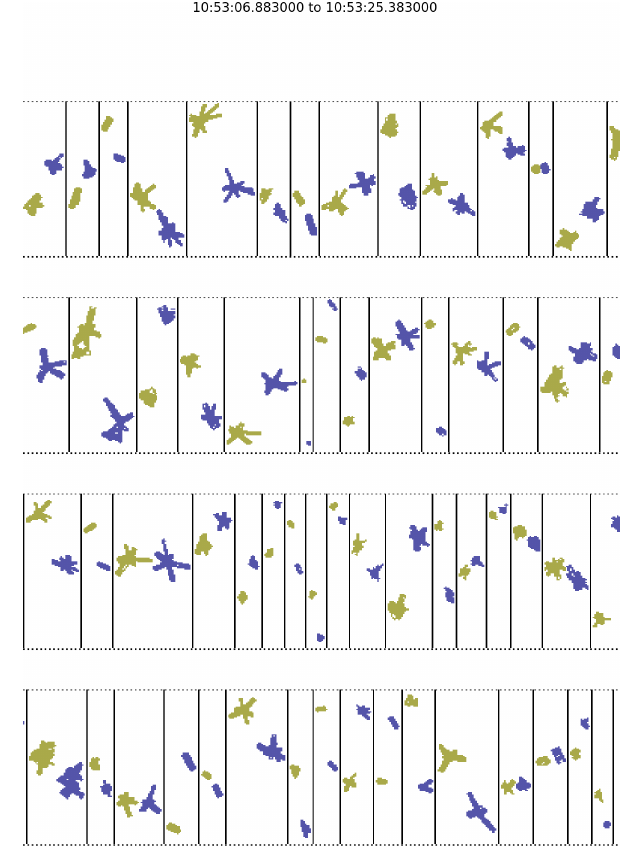
Figure 14. (a) Histograms of inter-arrival times for particles on the same 2D-S channel for measurements in cirrus on 7 February 2018. (b) A histogram of the difference in arrival time between a particle on one channel and their closest neighbour on the other channel.